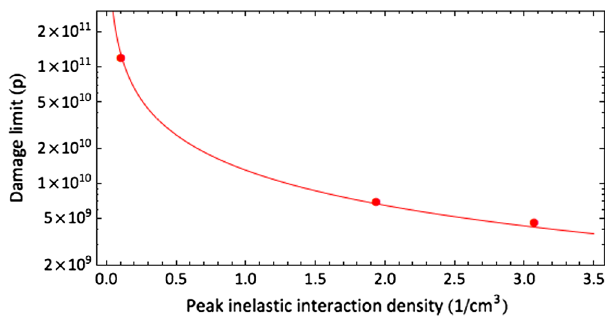
FIG. 24. Correlation between the peak probability density of inelastic interactions in the TCT and the damage limits calculated for threshold 1 in the simulated cases (from left to right: Case 1, Case 3 and Case 2). The line represents the fit function y ¼ c=z .